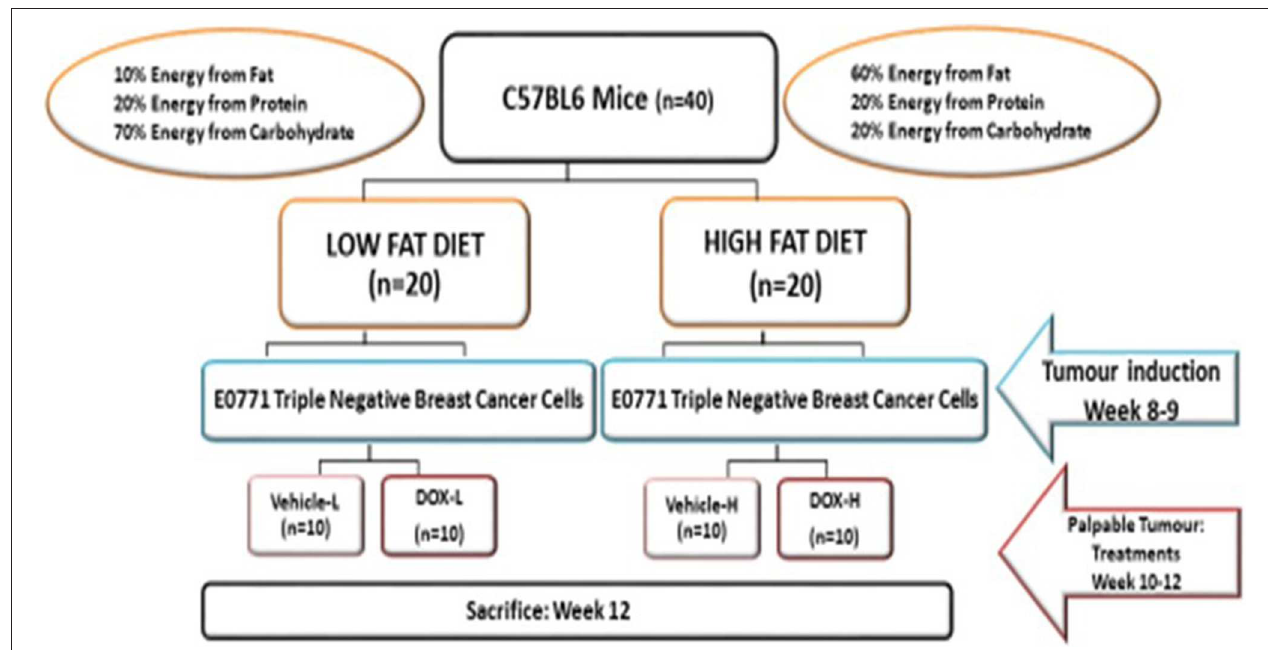
FIGURE 1 | Representative summary of the in vivo model and respective experimental